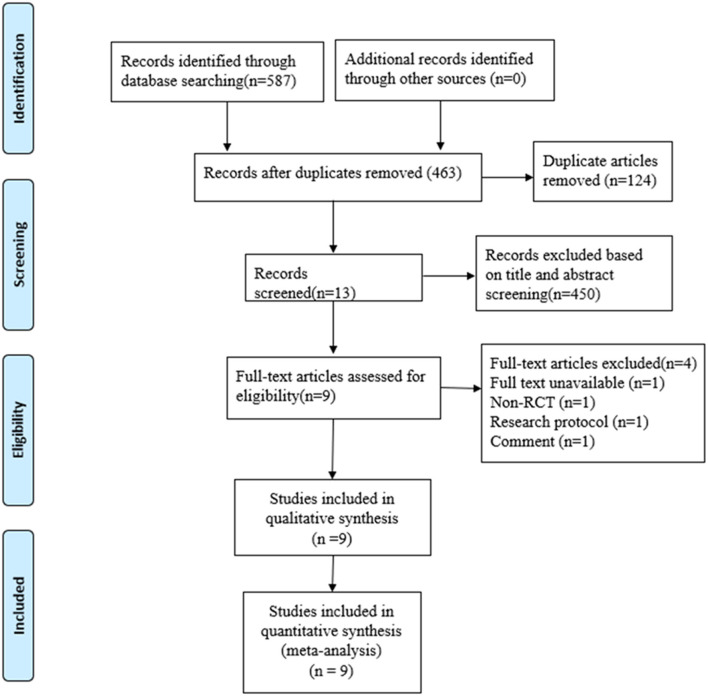
Flowchart of study selection.